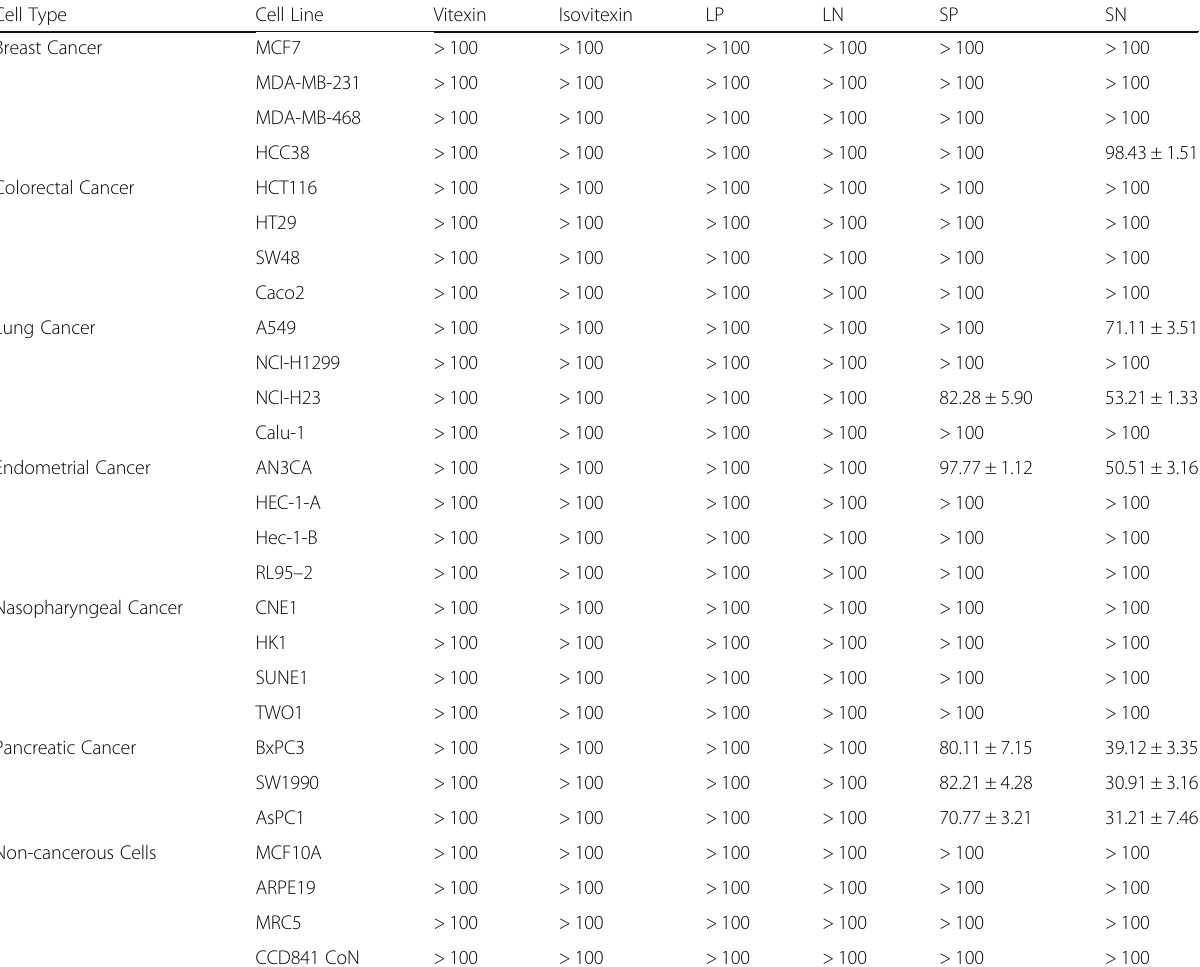
Table 1 The IC 50 of C. nutans Extracts on Cancer Cells Cell